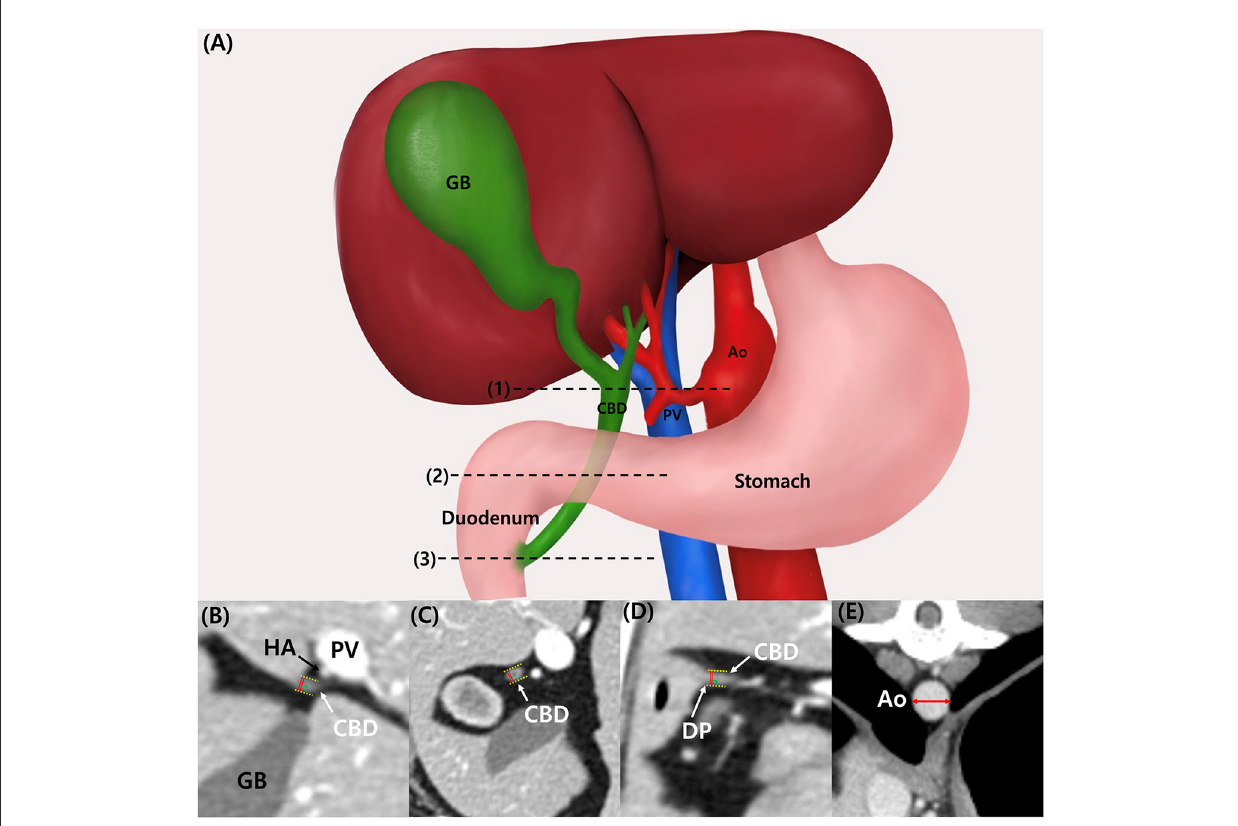
FIGURE1 Illustration of common bile duct in dogs. (A) The location of measurement of common bile duct diameter (CBD) were as following: porta hepatis (PH) level (1), duodenal papilla (DP) level (3), and mid-portion (Mid) between these points (2). CT images of CBD at PH level (B) , Mid-level (C) , and DP level (D) . The measurement of CBD is made including the ductal wall (yellow dotted line), and the widest diameter was measured (red line) perpendicular to its long axis. CT images of aortic diameter (Ao) measurement (E) . For the Ao measurement, minor axis diameter (red double arrow) was measured. Ao, aorta; CBD, common bile duct; CT, computed tomography; DP, duodenal papilla; GB, gallbladder; HA, hepatic artery, Mid, mid-portion; PH, porta hepatis; PV, portal